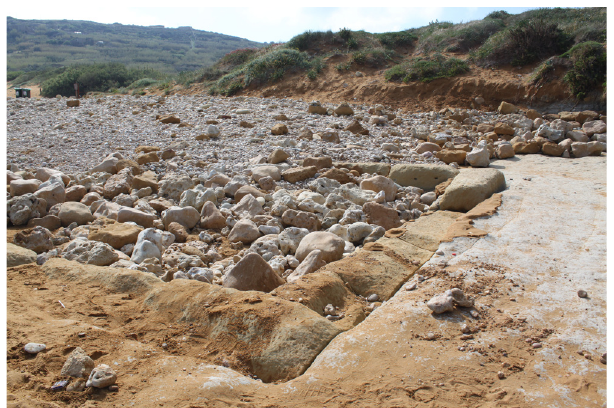
Figure 14: Full extent of one end of the newly uncovered ashlar alignment in 2012. A recently eroded section is clearly visible in the top right corner of the photo ( Source: Author ) .